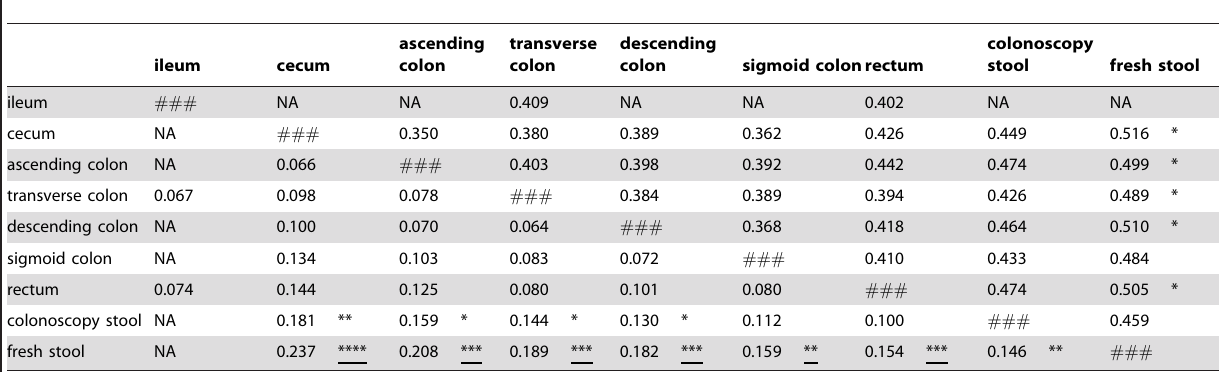
Table 2. UniFrac distances between the seven biopsies and two sampling types of